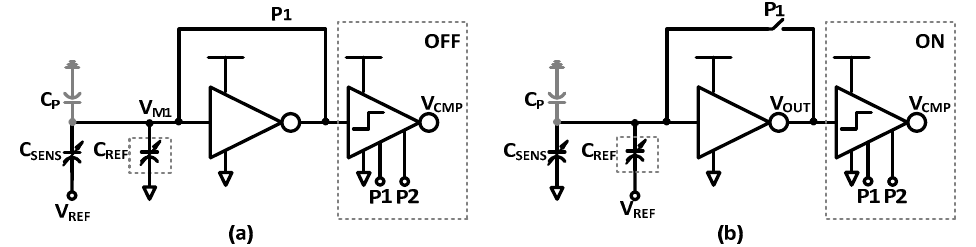
Figure 5. ( a ) Schematic and operation of sampling phase; ( b ) Schematic and operation of conversion